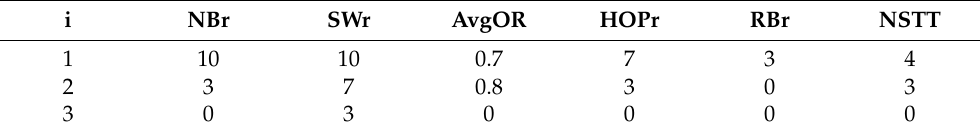
Table 2. Application example of the imbrical spreading function where (NB, SW)=(10,10).